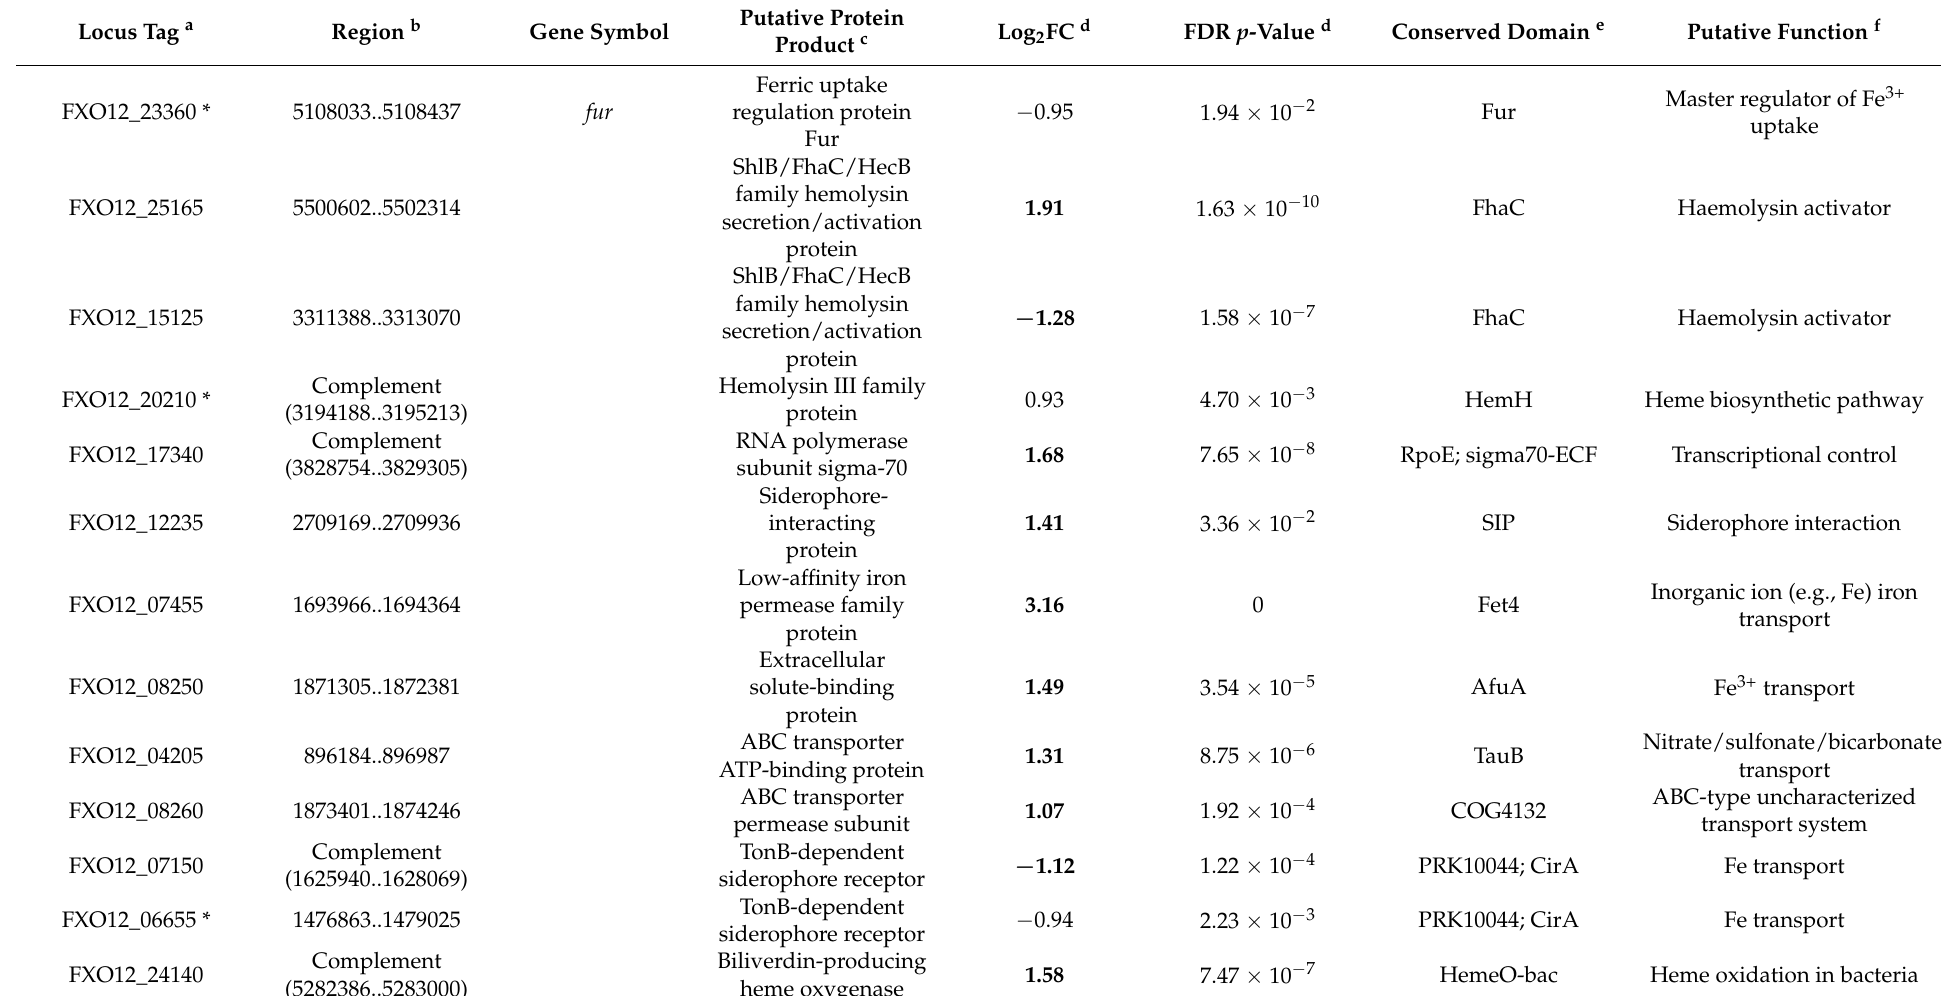
Table 4. Selected differentially-transcribed genes playing roles related to iron